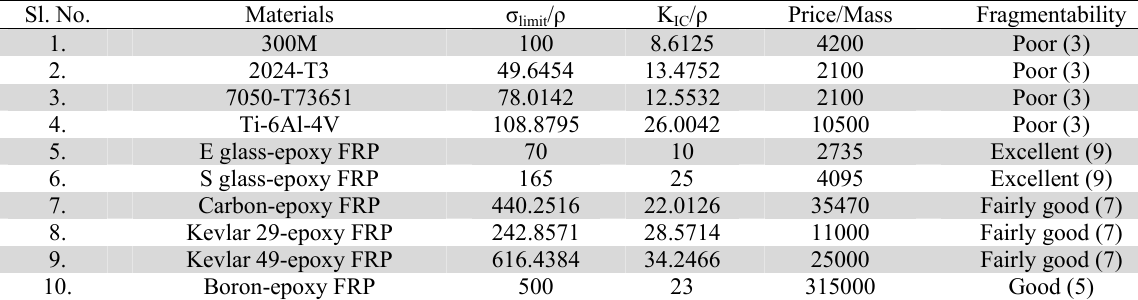
Quantitative data for flywheel material selection problem (Jee & Kang, 2000) Sl. No.